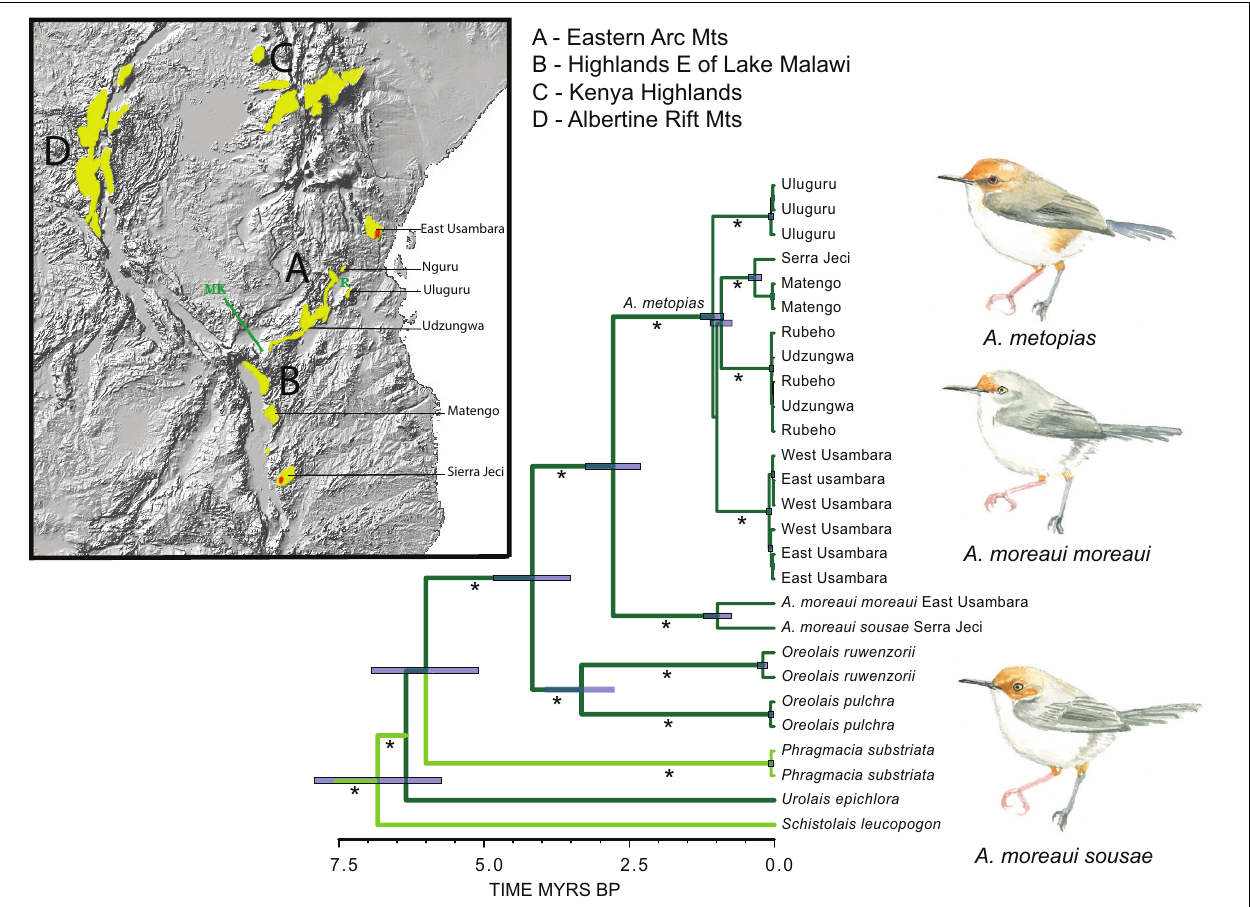
FIGURE 2 | Distributions of Oreolais species in the Albertine Rift ( O. ruwenzorii ) and Gregory Rift Mountains ( O. pulchra ) and Artisornis in the Eastern Arc Mountains ( A. metopias , and the relict distribution of A. moreaui in red); and phylogeny of these taxa and the deeply divergent Phragmacia of South African arid lowland habitats, and Urolais and Schistolais of the Guineo-Congolian rainforest region. The phylogeny is derived from a maximum likelihood analysis of seven genes using 13 partitions detailed in Bowie et al. (2018). Timing of divergence was estimated using the rates of nucleotide substitution reported by Lerner et al. (2011). On the map: R, Rubeho Mountains; MK, the Makambako Gap delineating the southern extent of the Eastern Arc Mountains. * > 75% bootstrap support. In this phylogeny (and for following illustrations), lineages associated with montane forest are marked with dark green and those in lowland habitats with light green.